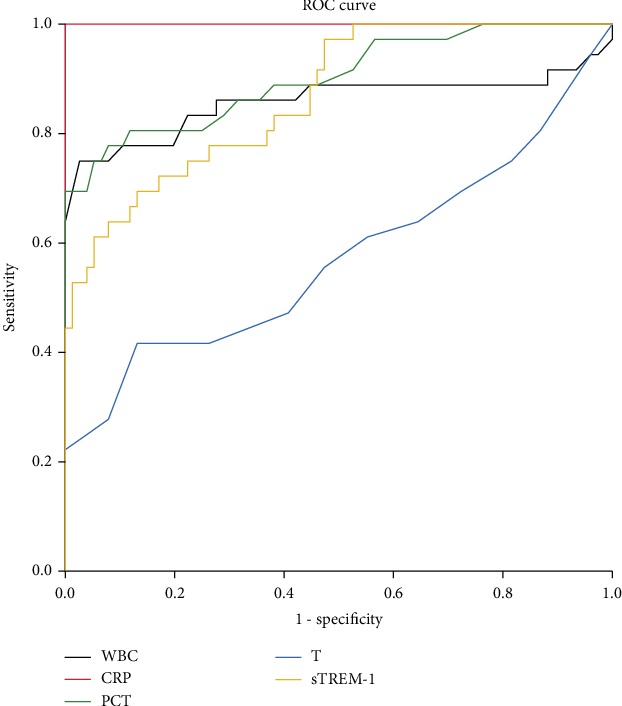
ROC curves of WBC, CRP, PCT, sTREM-1, PCT, and T between Group B and Group C. WBC (black): white blood cell; CRP (red): C-reactive protein; PCT (green): procalcitonin; sTREM-1 (yellow): soluble triggering receptor expressed on myeloid cells 1; T (blue): temperature. Group B: AC patients without sepsis; Group C: inpatients without AC or other infections.